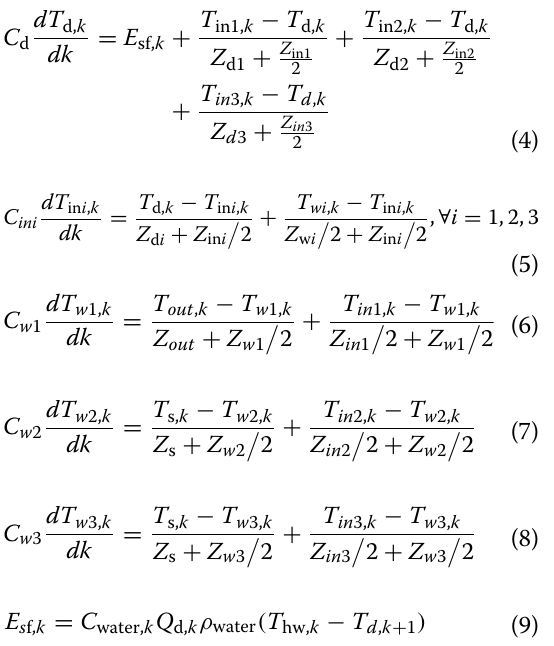
Fig. 2 Hydrodynamic model of the biogas generation